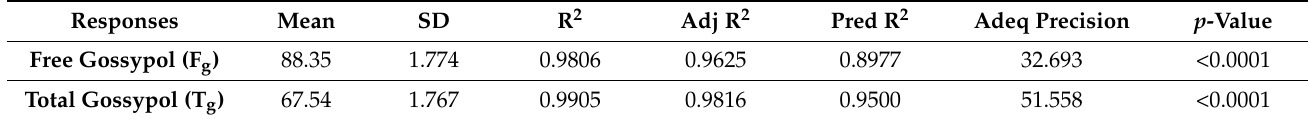
Table 4. ANOVA results for free gossypol and total gossypol reduction.